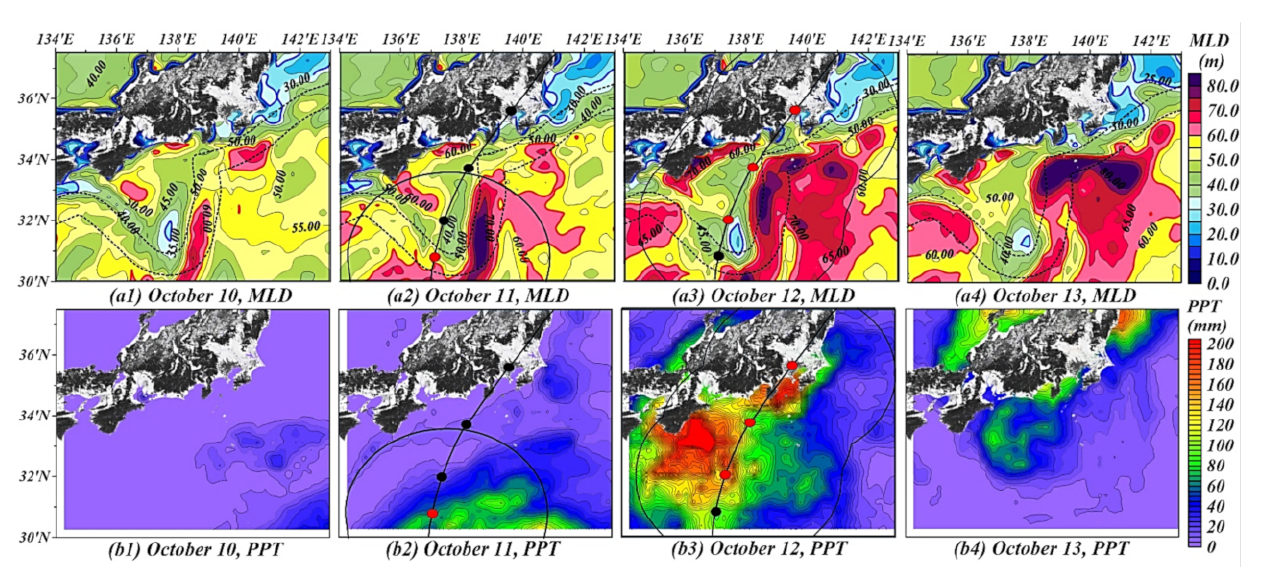
Figure 9. Daily mixed layer depth (MLD) and daily cumulative precipitation (PPT; mm); 10 October ( a1 , b1 ) 11 October ( a2 , b2 ) 12 October ( a3 , b3 ), and 13 October ( a4 , b4 ), respectively. Black dotted line, black line, and red dotted denote the Kuroshio meander, storm wind zone, and the location of the center typhoon corresponding date. The blue and red contour lines indicate 30 m and 60 m thickness in terms of MLD, respectively. Figure 9b indicates the daily precipitation distribution observed by TRMM